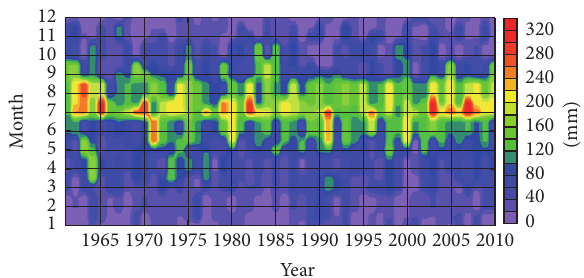
Figure 3: The visualization of temporal monthly precipitation distribution pattern of the